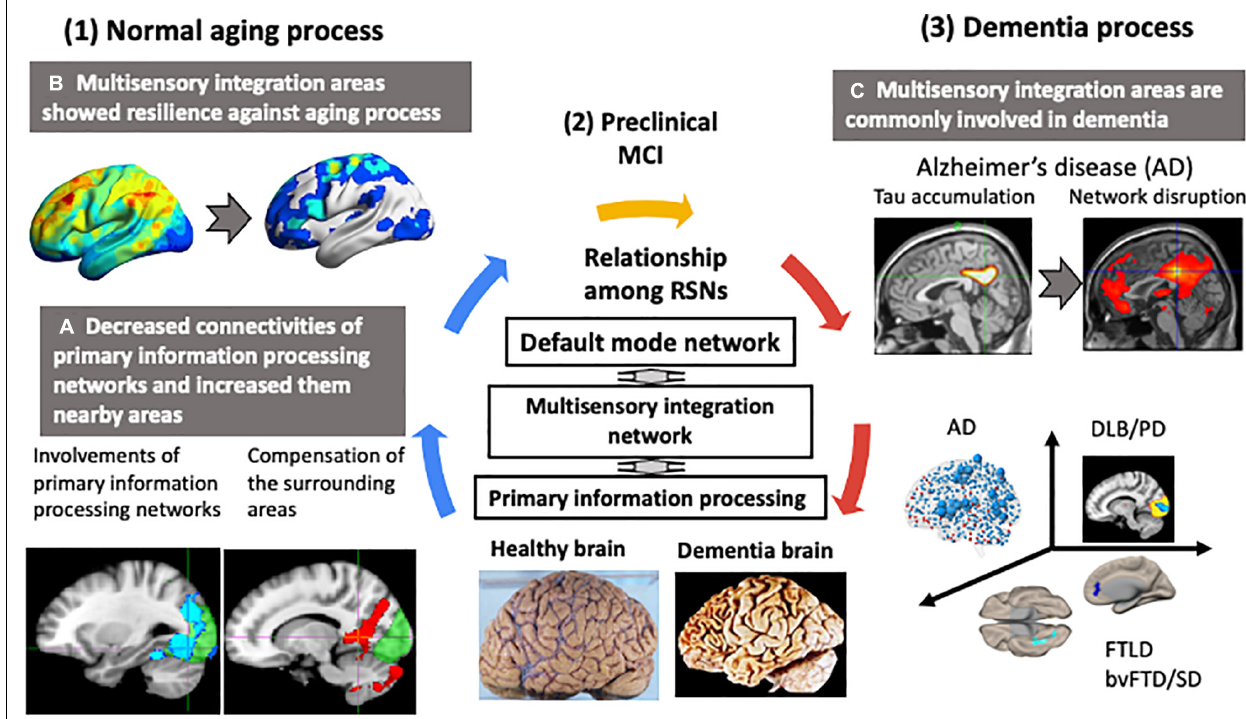
FIGURE 3 | Changes in functional networks with normal aging and dementia. Neurodegenerative dementias are commonly associated with impairments in the connector hub. In the resting state networks (RSNs) of the brain, a multisensory integration network connects each primary information processing network to the default mode network. The multisensory integration networks are closely connected to each other. In normal aging, the functional connectivity of the primary information processing networks decreased and connectivity of the surrounding regions centered on the multisensory integration networks increased. The functional connectivity of the multisensory integration networks was well-preserved with age. In contrast, in dementia, hub regions, such as the multisensory integration networks and the default mode network, were the preferred sites of lesions. Early-stage Alzheimer’s disease was characterized by tau accumulation and disrupted functional connectivity in the posterior cingulate gyrus and precuneus, which are the hubs of the default mode network. This vulnerability of the hub region to disruption was also seen in Parkinson’s disease with mild cognitive decline and in amyotrophic lateral sclerosis with behavior disorder and semantic impairment.